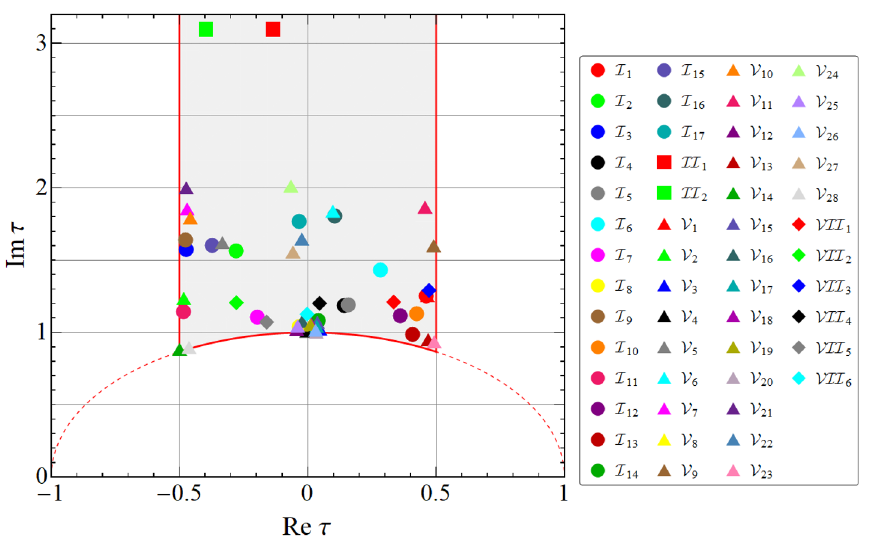
Figure 1 . The best fit values of the complex modulus τ for the viable models summarized in